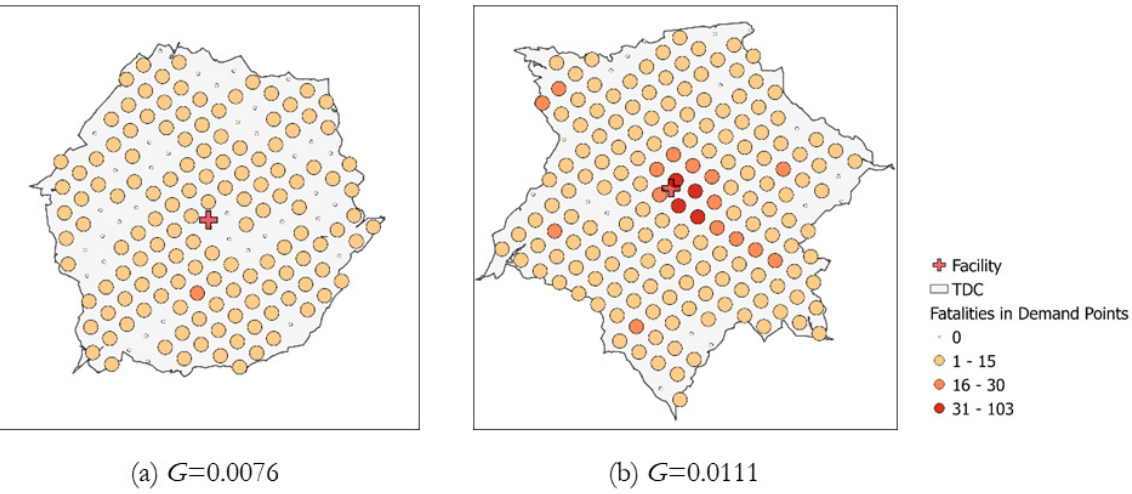
Figure 1. Computations of global G -statistic for TDCs with different intensity of fatalities. ( a ) G = 0.0076; (b) G = 0.0111